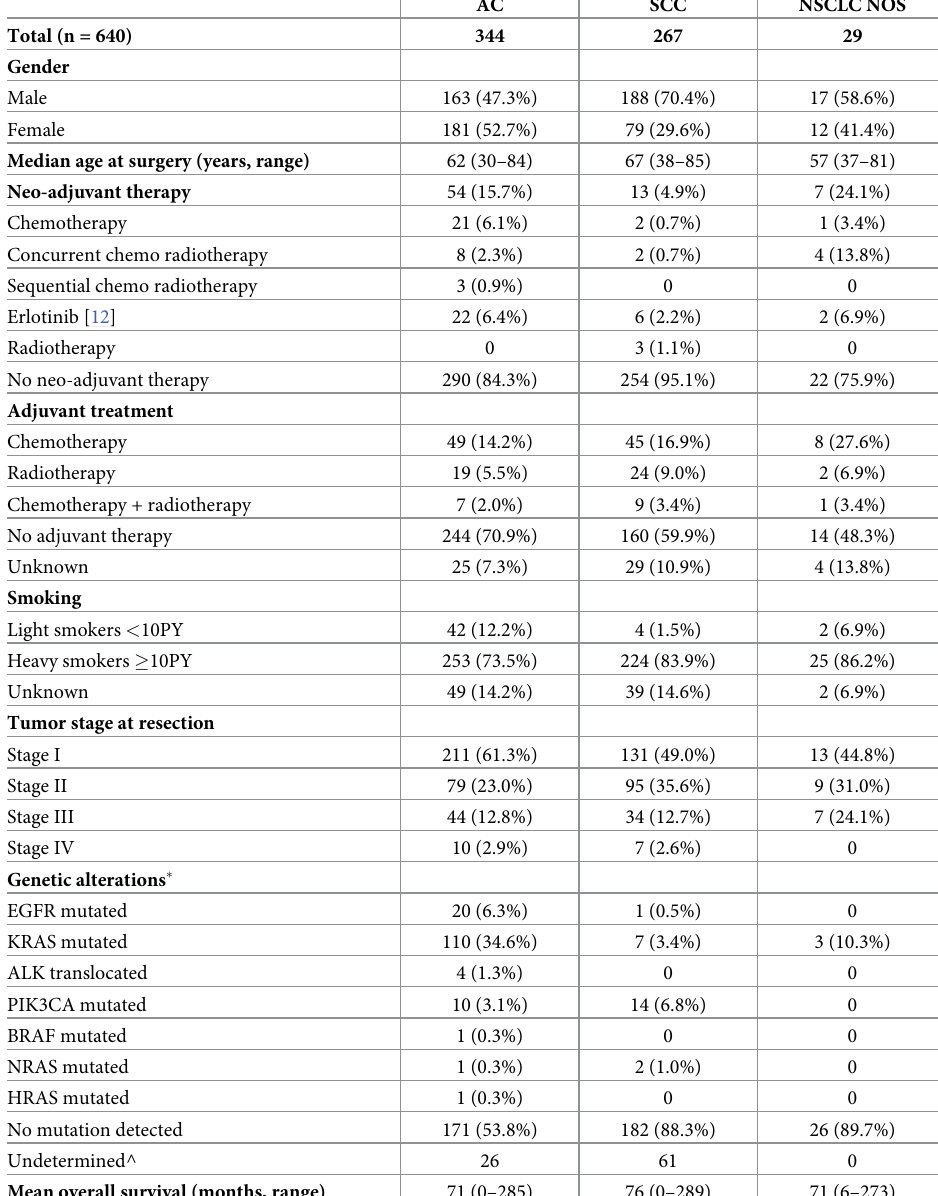
Table 1. Patients’ and tumor characteristics of the non-small cell lung cancer